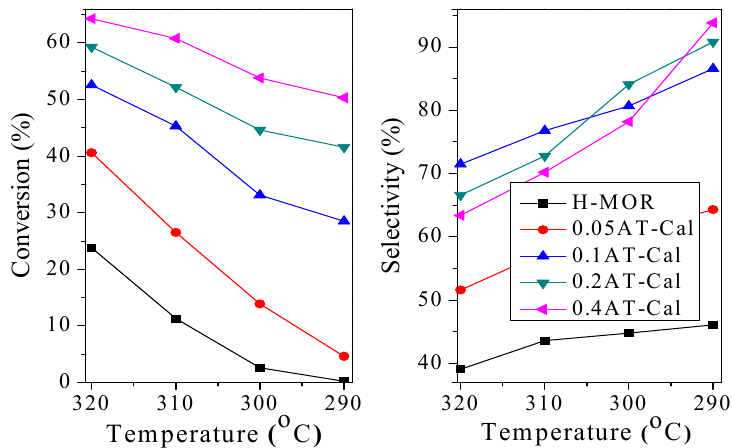
Figure 7. Effect of reaction temperature on the catalytic performance. Reaction conditions: pressure